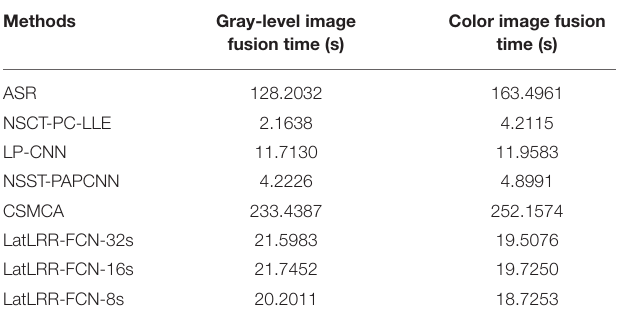
TABLE 3 | Computation cost of different